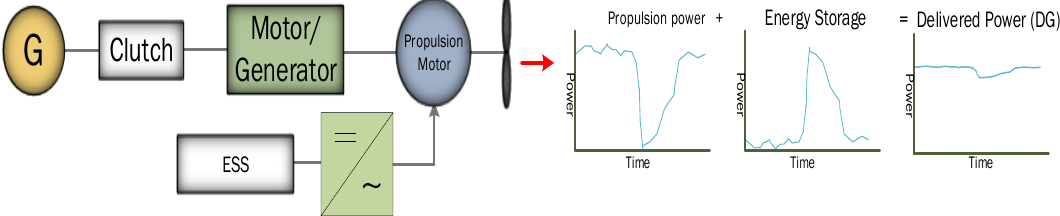
Figure 16. Power Smoothing utilizing energy storage